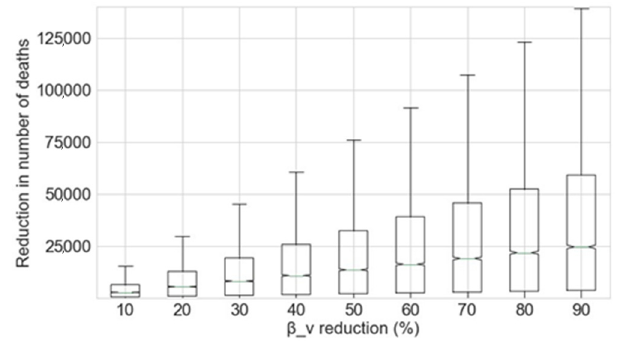
Figure 7. Reduction in the number of deaths as a function of the percentage decrease in β v , given that this reduction is applied from June 2020. Table 3. Relationship between the decrease in β v and the resultant number of deaths avoided when this decrease is applied from June 2020 expressed as the mean value of the Monte Carlo simulation.